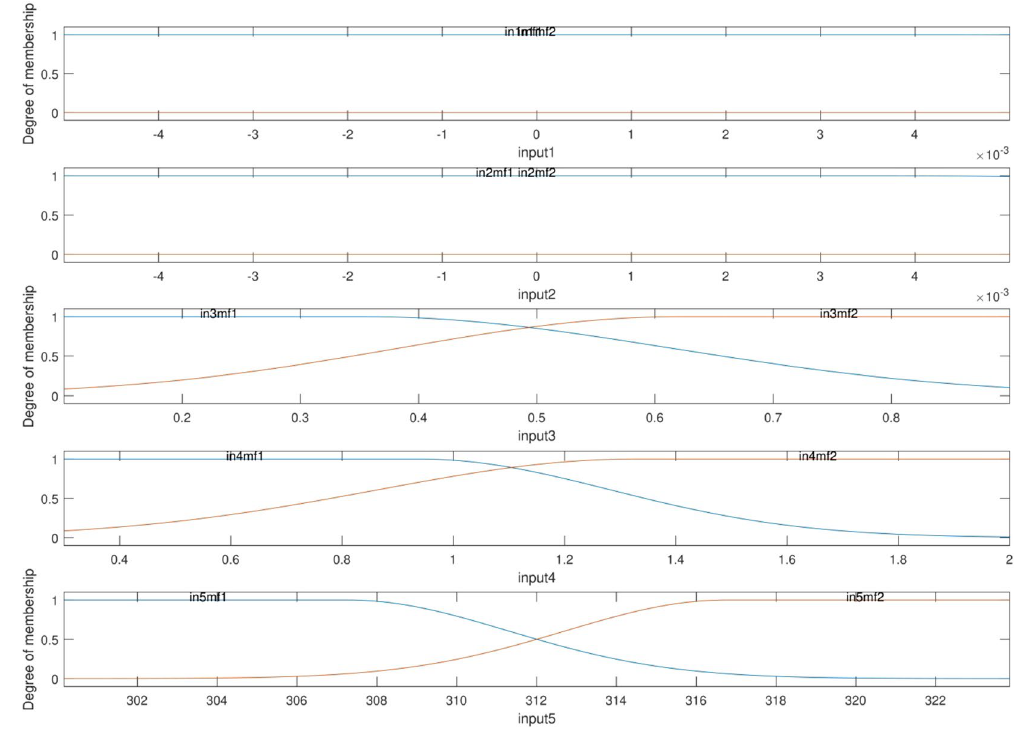
Figure 9. The degree of membership plots. The number of inputs = 5. MF is